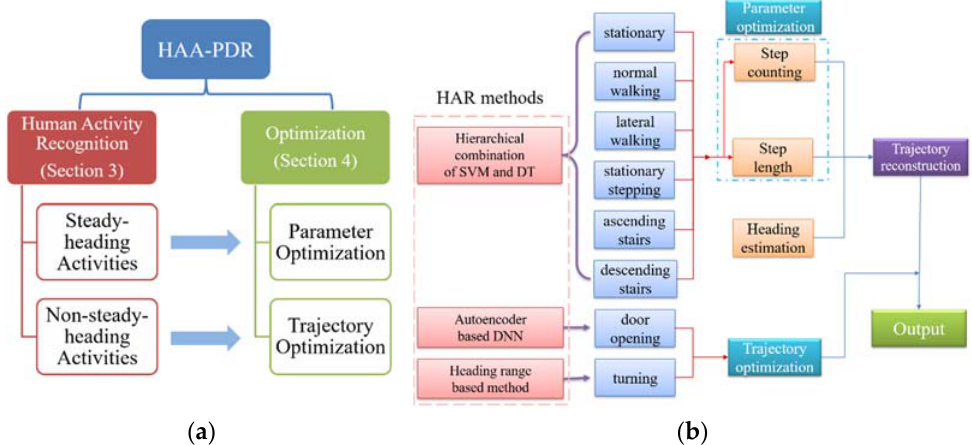
Figure 1. The framework of the HAA-PDR system. ( a ) is the outline of proposed HAA-PDR system, and ( b ) is the detailed process flow of this system.